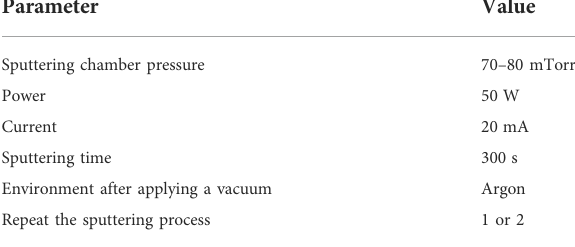
TABLE 2 Parameters of sputtering process for gold electrode fabrication.